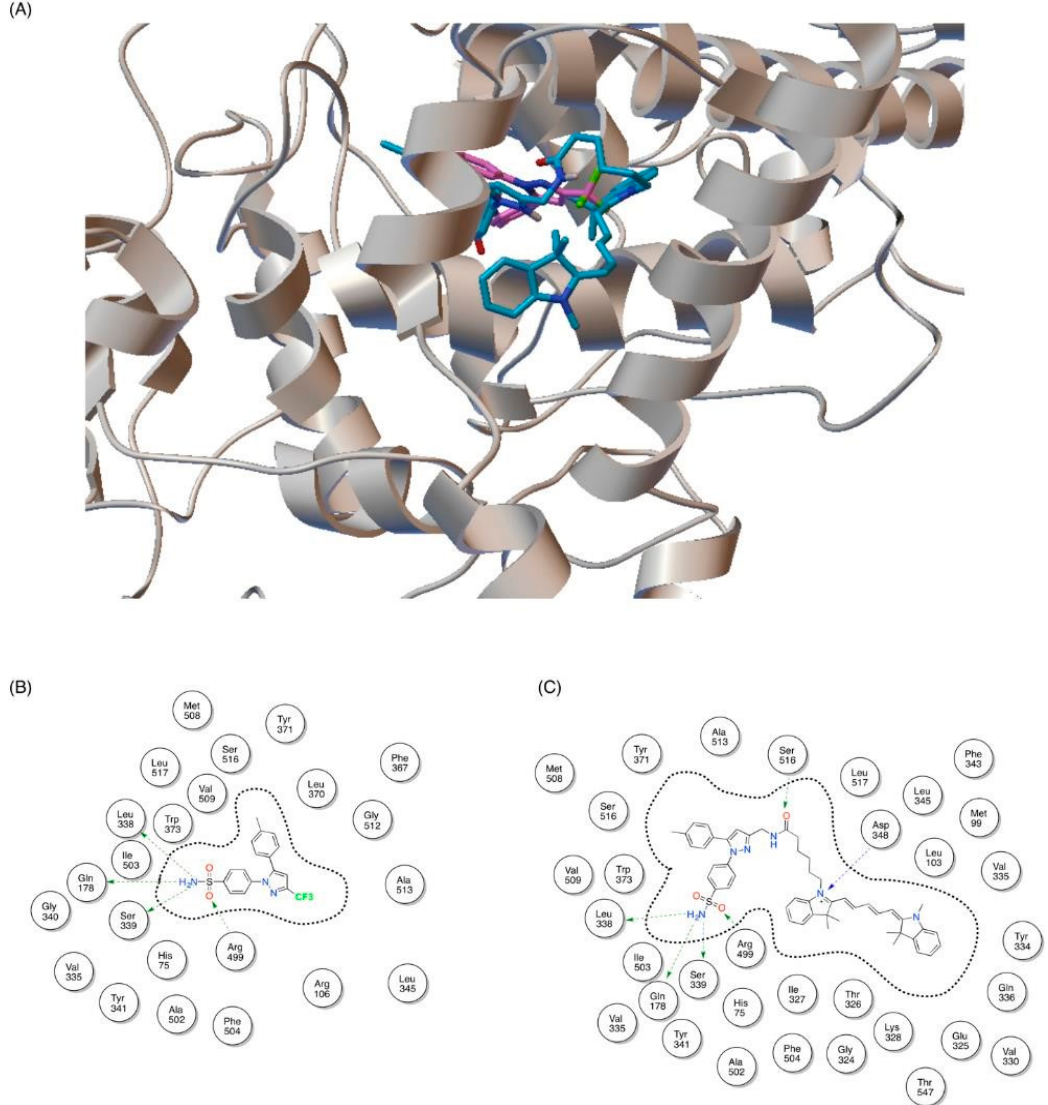
Figure 3. The binding modes of celecoxib and compound CCY-5 in COX-2. ( A ) 3D representation for both compounds, COX-2 binding study of celecoxib analogues. The binding modes of celecoxib (pink) and compound CCY-5 (green) at the active site of COX-2. ( B ) 2D diagram for celecoxib; ( C ) 2D diagram for CCY-5.